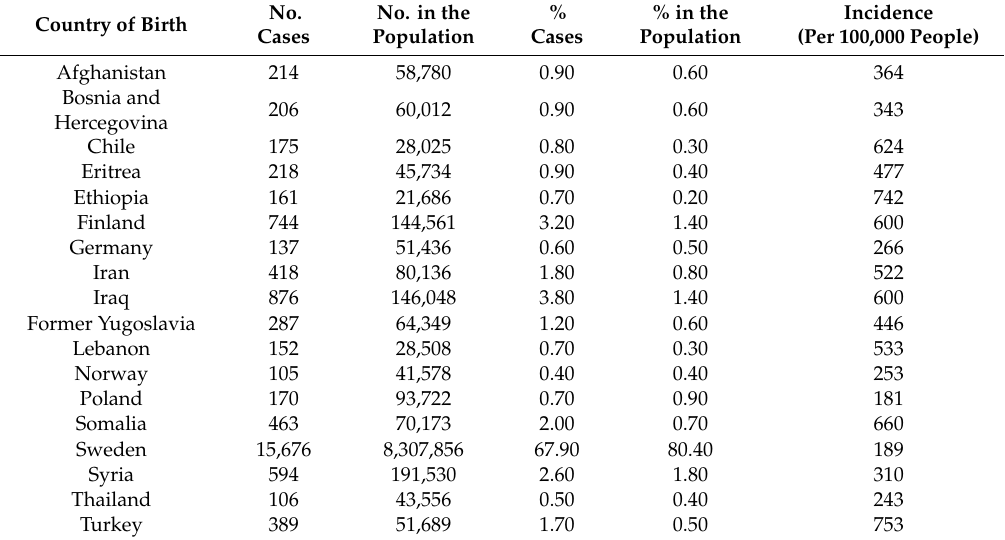
Table 1. Report by Swedish Public Health Agency (Folkhälsomyndigheten) on the number of cases and incidence of COVID-19 per country of birth during the period of 13 March–7 May 2020 [7]. No. No. in the % % in the Incidence Country of Birth Cases Population Cases Population (Per 100,000 People) Afghanistan